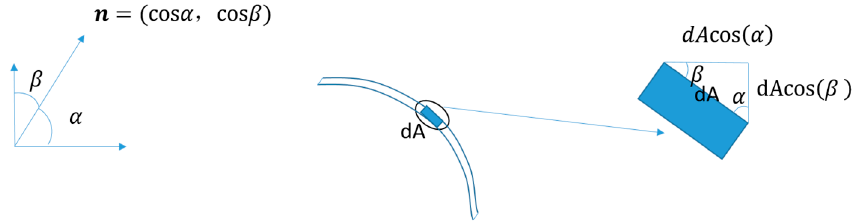
Figure 8. A micro-element taken on the surface of the geometry.